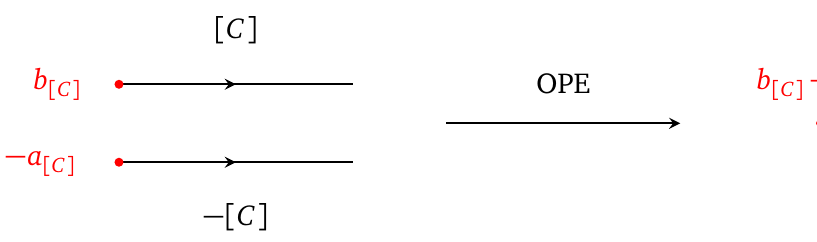
Figure 4: Taking OPE of two local operators living at the ends of two line defects that are inverse of each other leads to a genuine local operator. The flavor center charges are added in this process.